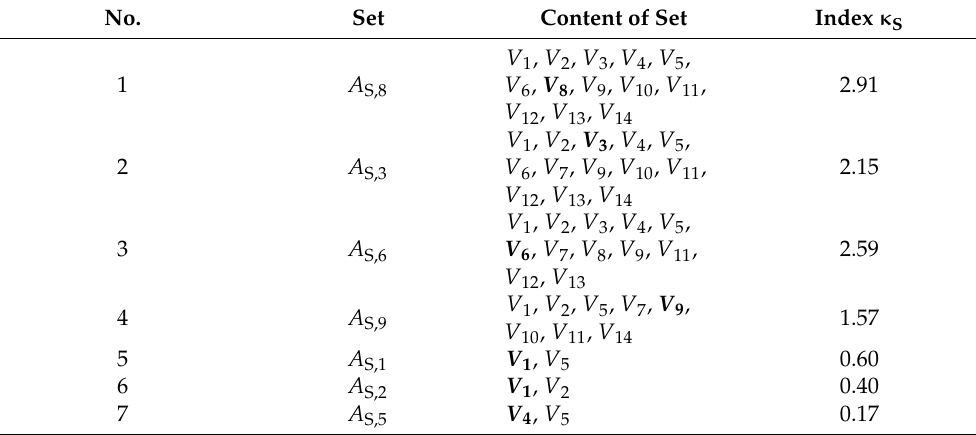
Table 6. The Ranking List of the Sets A S, j j ∈ {1, 2, . . . , 14}, when the Cardinality of a Set is Adopted as a